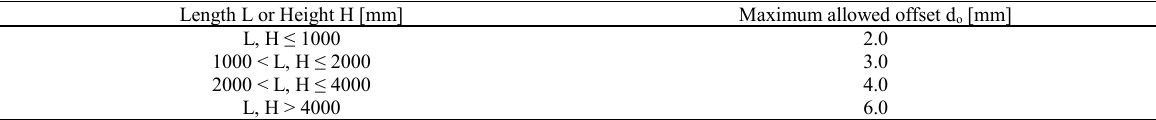
Table 1: Maximum allowed edge offset do according to EN ISO 12543-5 table